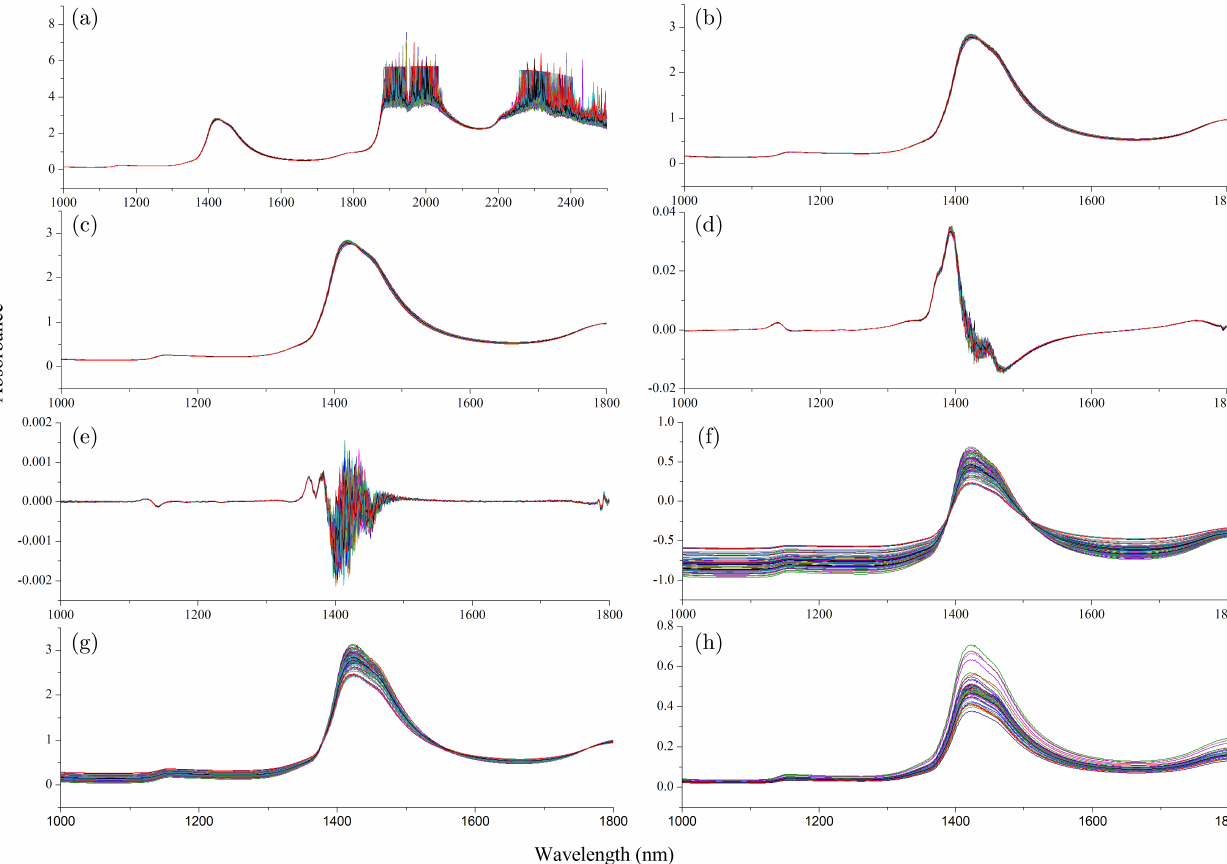
Fig. 3. Raw NIR spectra of full wavelength (a), raw NIR spectra (b) and spectra preprocessed using SG smoothing (c), one- dimensional convolution (d), two-dimensional convolution (d), SNV (e), MSC (f) and normalization of selected wavelength (g) of test samples.